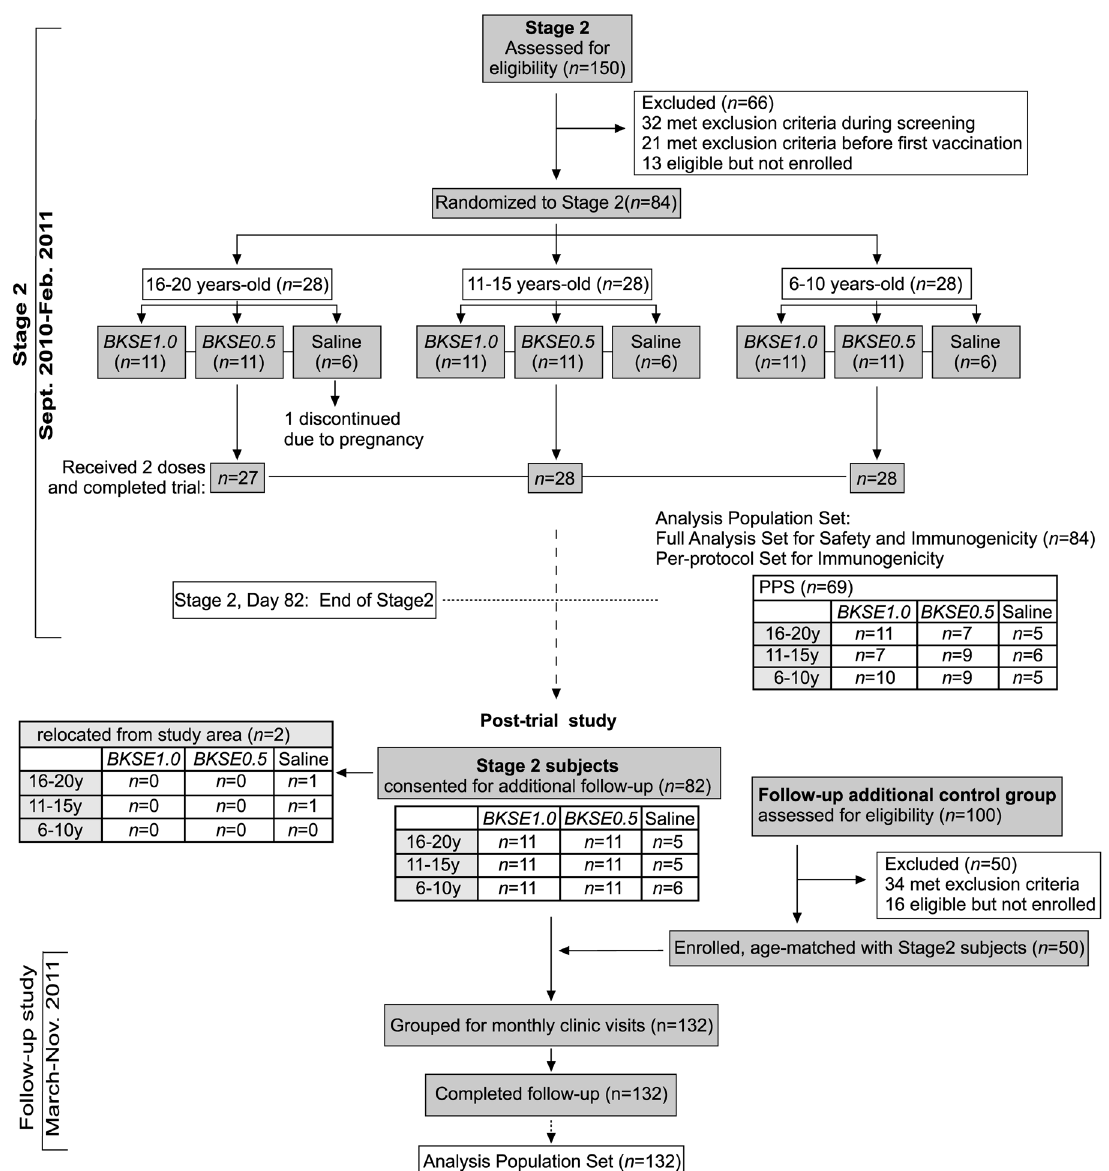
Figure 2. Enrollment and outcomes for Stage2. Trial schedule was similar to Stage1. Ethical clearance for a longitudinal study with additional age-match control group (no intervention) was approved after the trial. In the follow-up study, scheduled four weekly visits continued for up to 1- year post-second vaccination.